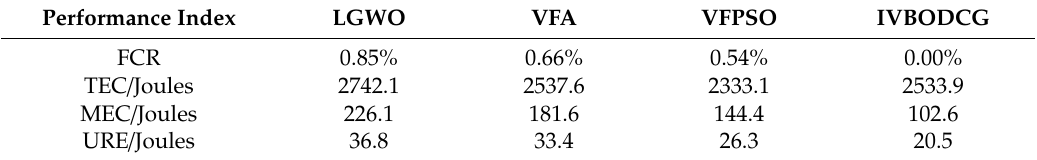
Figure 15. Comparison of statistical results of the four algorithms from 200 experiments. ( a – d ) show the statistical results of final coverage rate, total energy cost, the maximum energy cost and uniformity of residual energy of four algorithms, respectively. Table 3. Performance comparison of 200 simulation experiments in standard